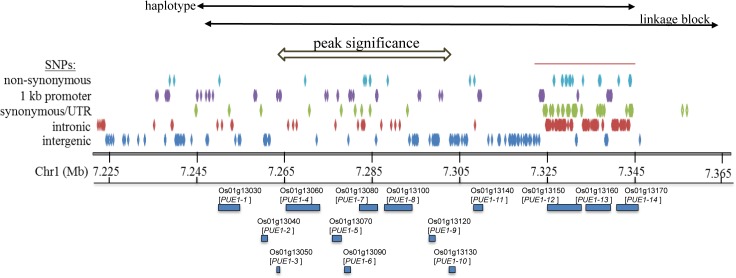
In silico investigation of SNP variation and predicted gene models (MSU6.1) across the indica specific PUE locus on chromosome1, delimited by haplotype and linkage block to 7.247–7.343 Mb.The location of SNP locations with most significant association to PUE is indicated. SNP patterns shown are based on 1479 accessions represented in the RiceVarMap database and indicate specific SNPs detected in accessions belonging to the rare high-PUE haplotype (HT1-7) group (haplotype frequence of 7.3%). A total of 550 SNPs are displayed, of which 332 SNPs cluster towards the downstream limit (red bar on top).